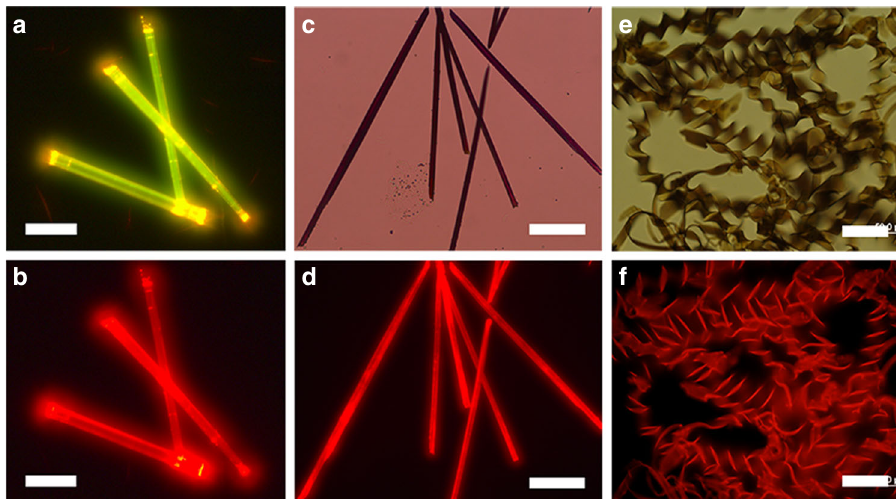
Fig. 5 Optical characterization of BA, BN, and (BA) 0.72 (BN) 0.28 helical assemblies. When excited by ( a ) blue and ( b , d and f ) green light, fl uorescence microscopy images of ( a , b ) BA tubes, ( d ) BN tubes, and ( f ) (BA) 0.72 (BN) 0.28 helices. Scale bars, 25 μ m in a , b , 50 μ m in d , and 20 μ m in f . Bright- fi eld optical microscopy images of ( c ) BN tubes and ( e ) (BA) 0.72 (BN) 0.28 helices. Scale bars, 50 μ m in c and 20 μ m in